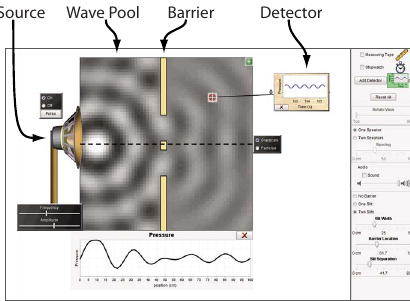
FIG. 1. (cid:1) Color (cid:2) Sound tab of Wave Interference . Each tab uses the same basic layout. The source (cid:1) here a loud speaker (cid:2) can alter- natively be a faucet (cid:1) water wave (cid:2) or flashlight (cid:1) light wave (cid:2) . The gray wave shown here can represent a water wave, sound wave, or light wave. The source, wave color, and graph labels change de- pending on the phenomenon represented. The graph at the bottom shows the wave along the dashed line in the pool. A barrier with one or two slits can be placed in the wave pool . A detector is used to measure the wave activity at different points in the pool.